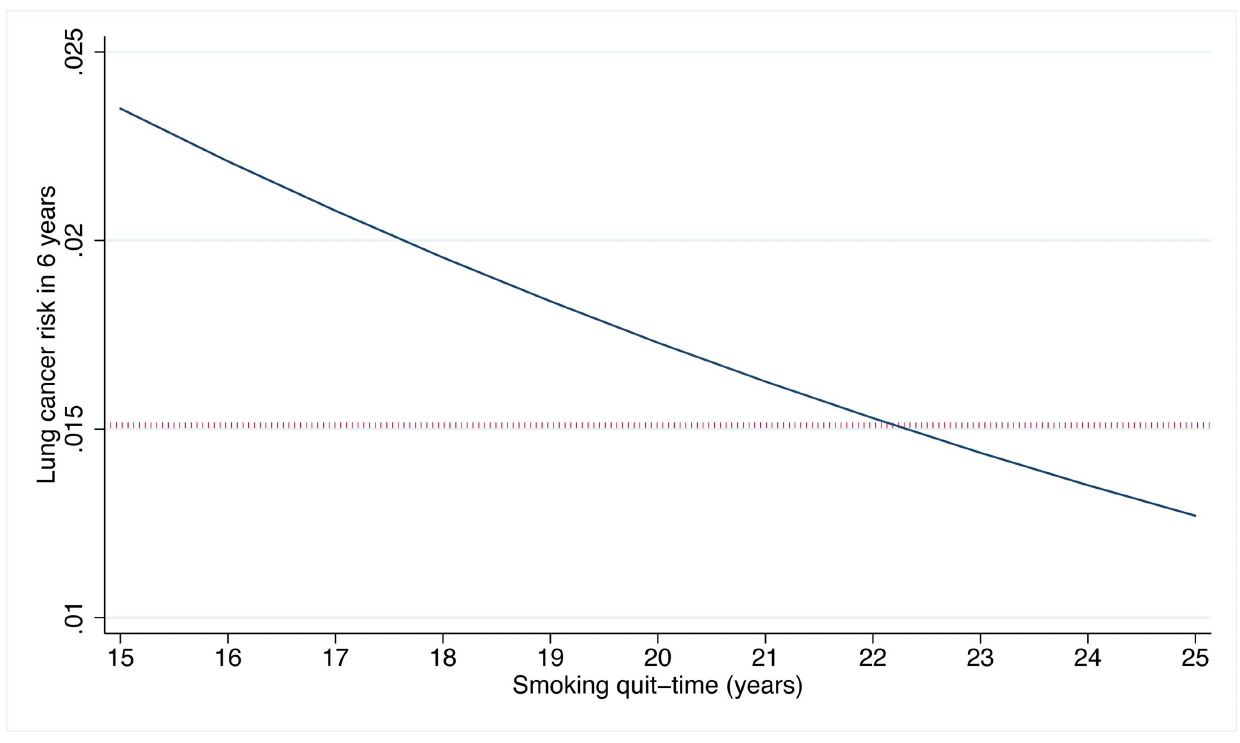
Figure 5. PLCO m2012 -estimated risks for high-risk individuals by smoking quit time in former smokers. Estimates were prepared for white former smokers who are 68 y old, are high-school graduates, have a body mass index of 27 kg/m 2 , have no family history of lung cancer, have no personal history of cancer, started smoking at age 14 y, and smoked on average 30 cigarettes per day. As the quit time increases, smoking duration correspondingly decreases. The dotted horizontal line indicates the PLCO m2012 $ 0.0151 risk threshold. PLCO m2012 refers to the lung cancer risk prediction model described in [11].